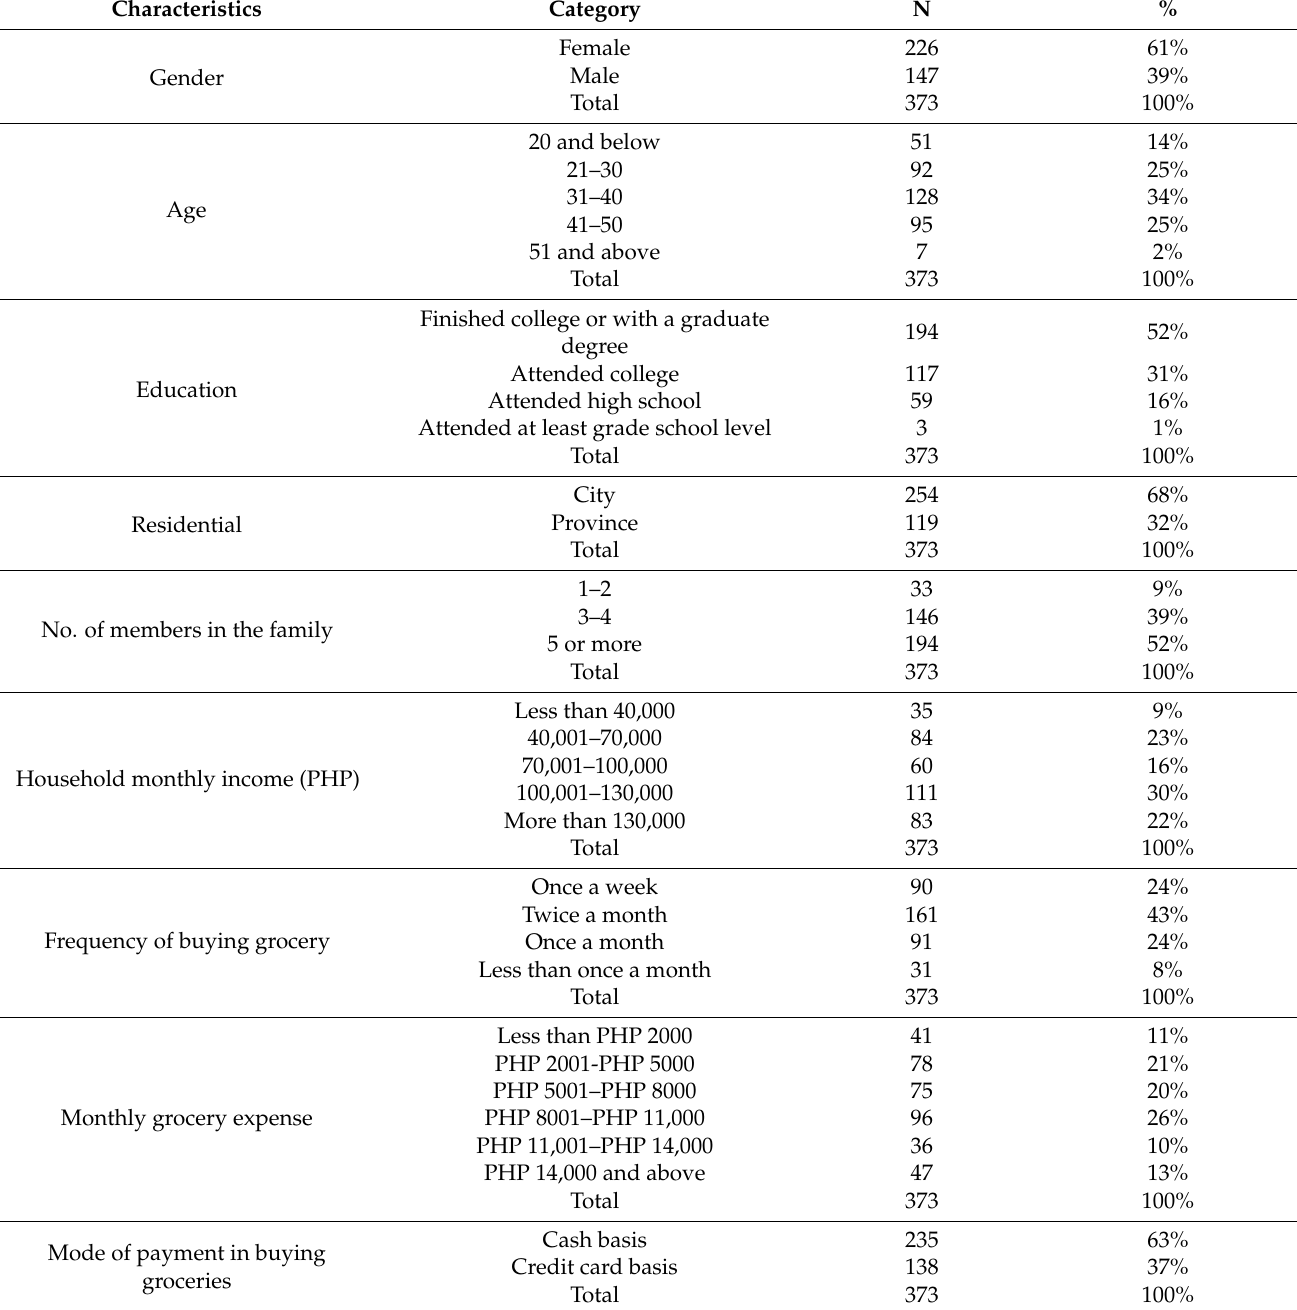
Table 2. The respondents’ descriptive statistics (n =